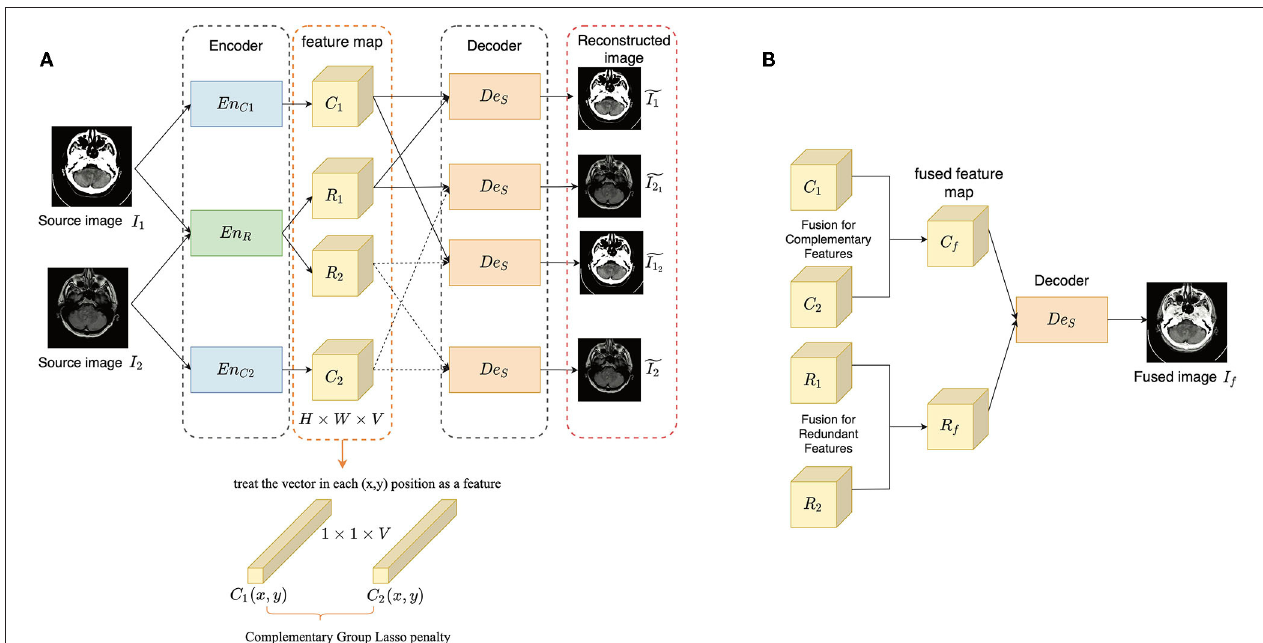
FIGURE 1 | The overview of the proposed method: (A) the training stage; (B) the fusion stage. The encoder-decoder architecture contains two complementary encoders En C 1 and En C 2 , one redundant encoder En R and one shared decoder De S . The extracted complementary and redundant features of the two source images are denoted as C and R ( 1,2), and each of them is of size H ∗ ∈ ∗ ∗